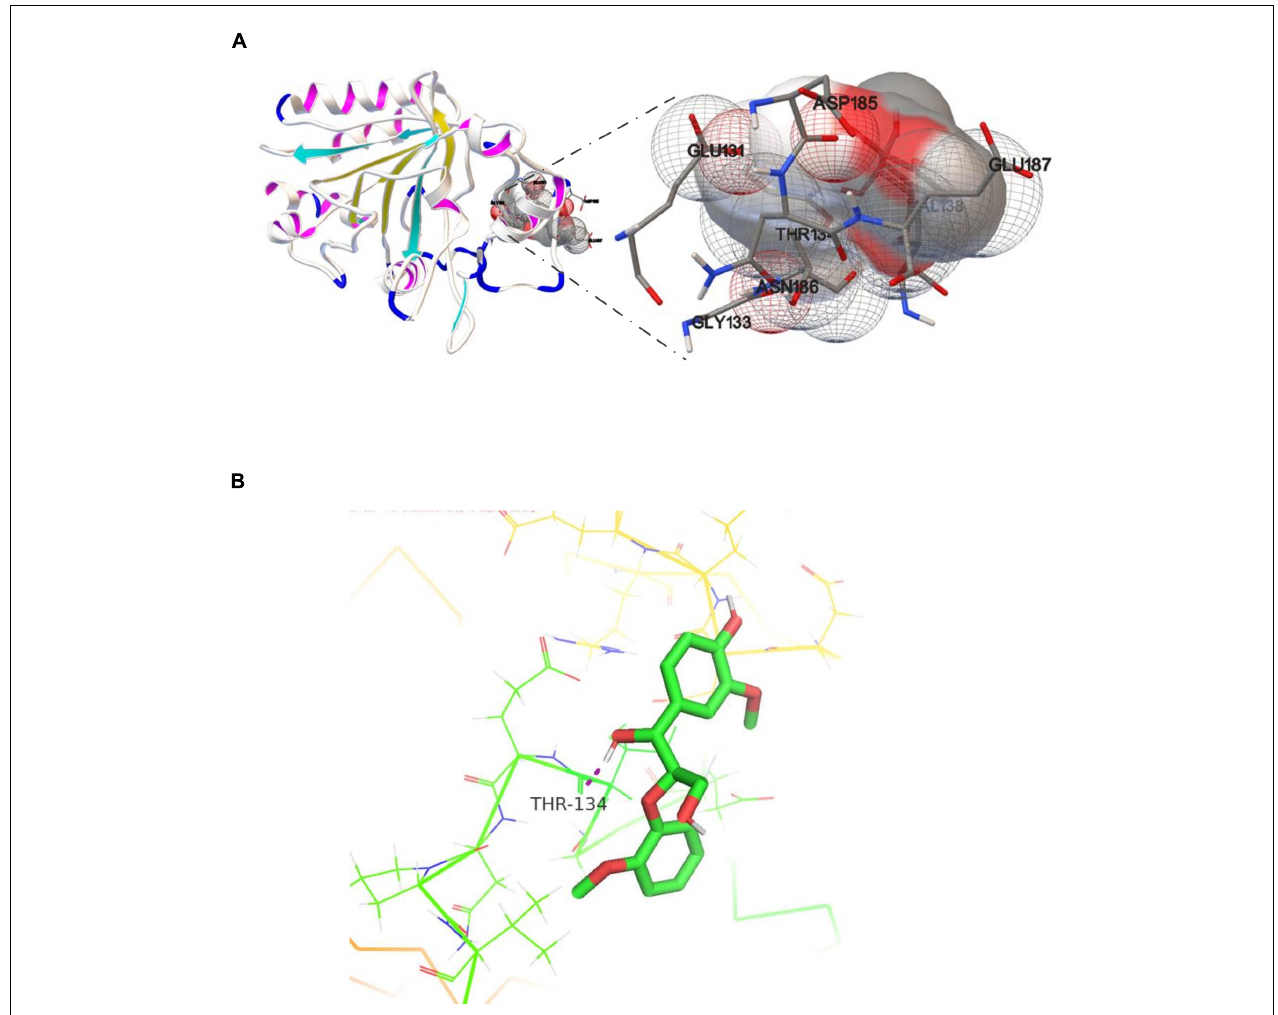
FIGURE 6 | (A) The molecular docking result of recombinant OhLac and GGE, (B) The hydrogen bonding between GGE and